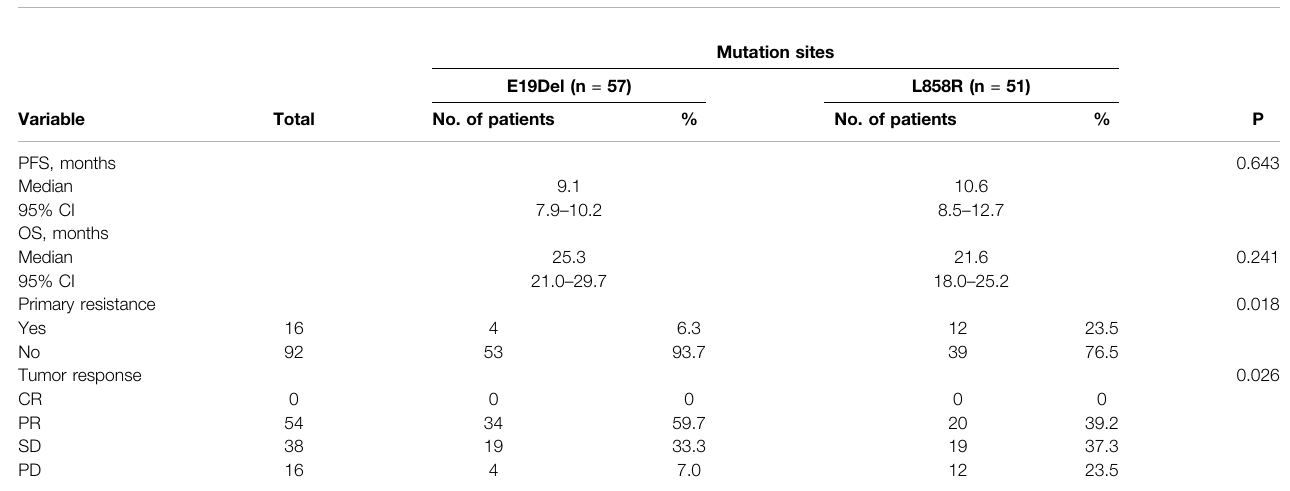
TABLE 4 | Ef fi cacy of EGFR 19Del and EGFR 21 L858R mutation.